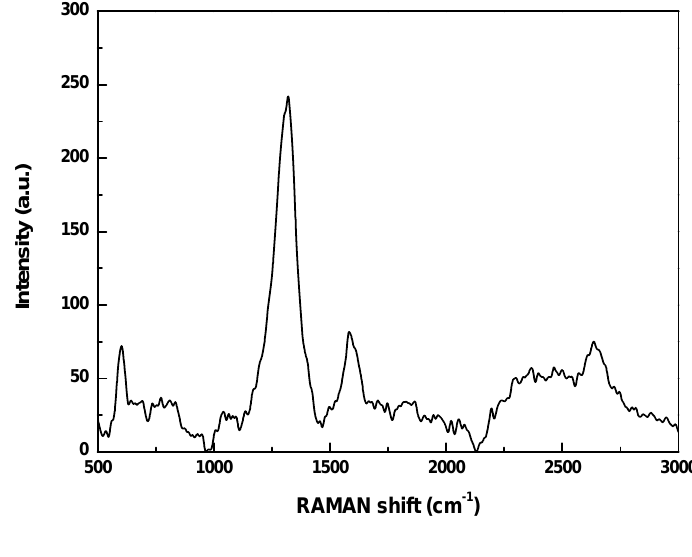
Figure 5. Thermogravimetry analysis (TGA) analysis of propanol-based